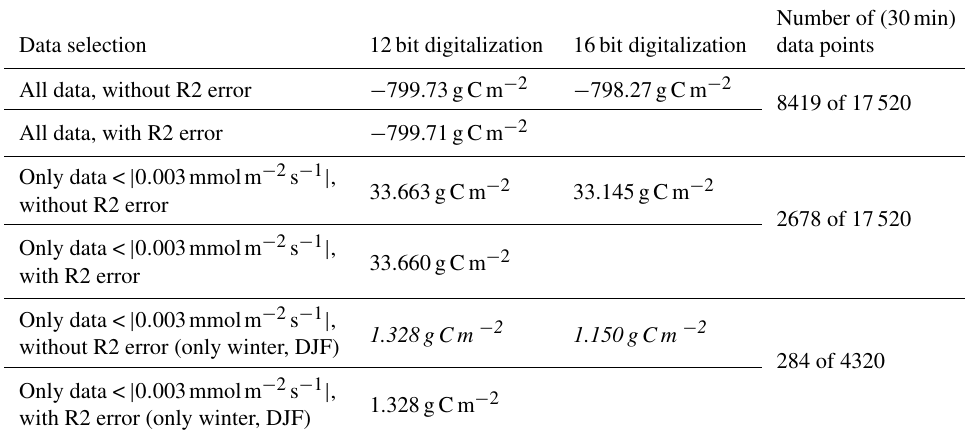
Table 2. Annual sum of NEE with 12bit and 16bit digitalization and with and without R2 instrumental error (the data were not gap-filled, and therefore the sum is larger than expected; relevant differences are in